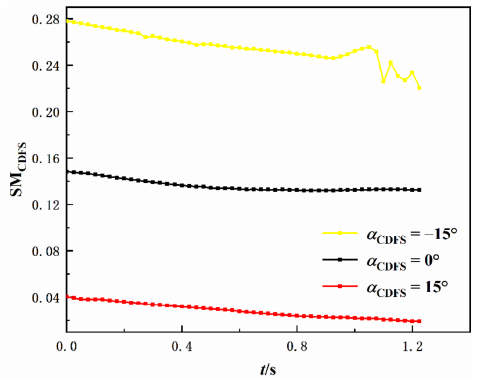
Figure 13. Surge margin of CDFS under different guide vane angles.